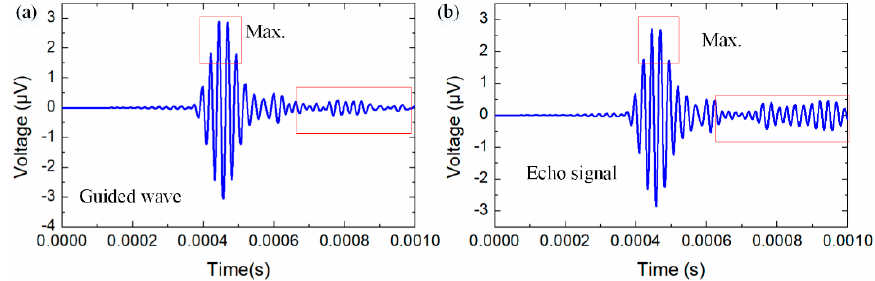
Figure 7. ( a ) Lamb guided wave and ( b ) echo signal for active damage detection of the rail.